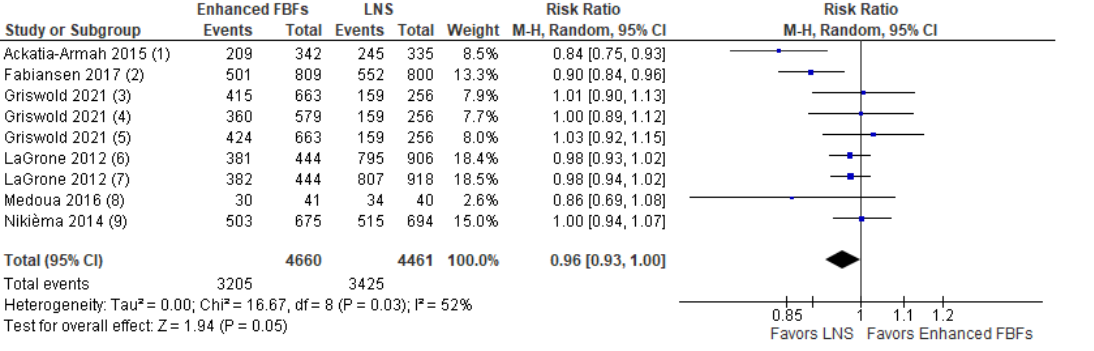
Figure 4. Forest plot of enhanced FBF compared to LNS—Outcome: Recovery rate (1) CSB++ Supplementary Plumpy/Nutriset; Recovery defined as WLZ > − 2.0 and MUAC >12.5 cm for >= 2 follow-up visits; (2) Enhanced FBF vs LNS, factorial trial including 12 different products; Recovery at 12 weeks (WHZ >= − 2 and MUAC >= 125 mm); Supercereal Plus with amylase (SC + A) vs RUSF; Recovery defined as achieving MUAC ≥ 12.5 cm by the seventh visit and no bipedal oedema; (3) Corn–